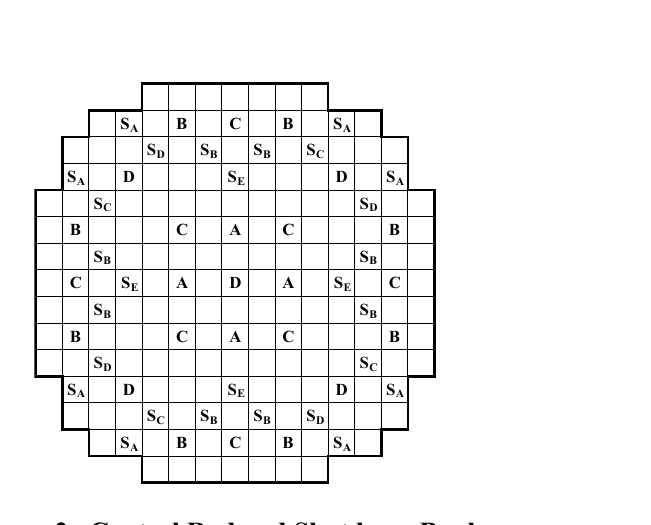
Figure 2. Control Rod and Shutdown Banks.